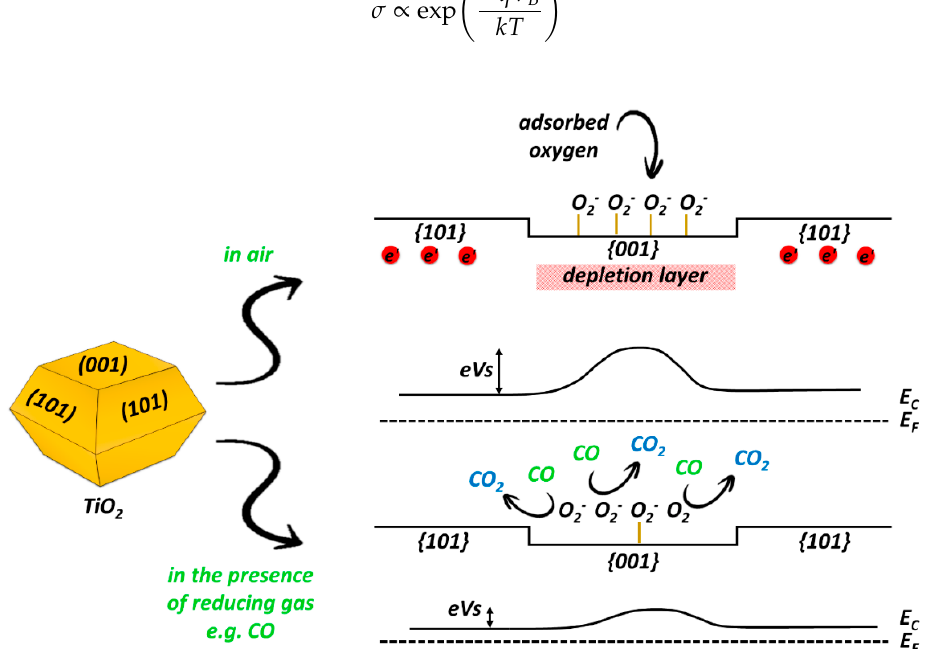
Figure 8. Schematic illustration of facet-dependent sensing mechanism for n-type semiconductor in the presence of air and reducing gas e.g., CO.